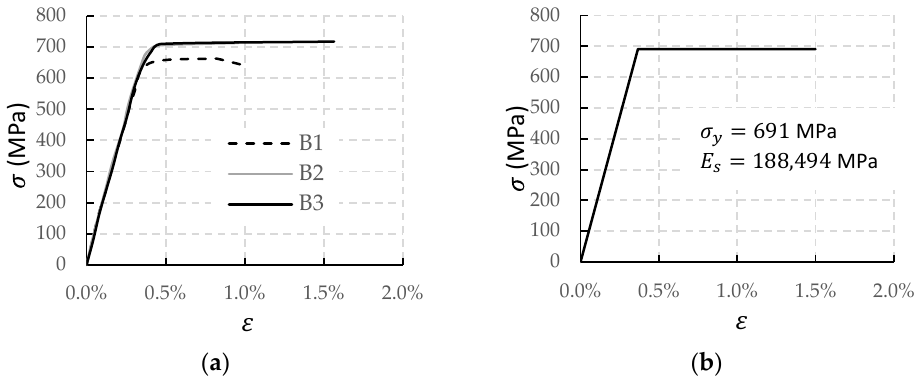
Figure 4. Stress – strain curve of joint reinforcement. ( a ) curves of samples tested, ( b ) average curve.